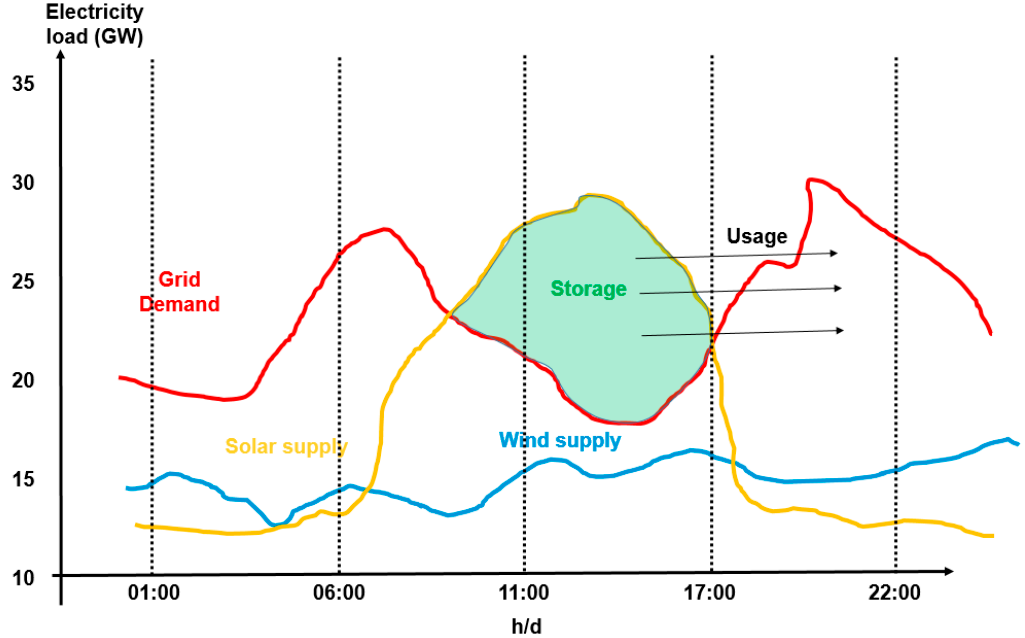
Figure 4. Utilising stored renewable energy surplus to satisfy the energy demand, adapted from Movallen [25].